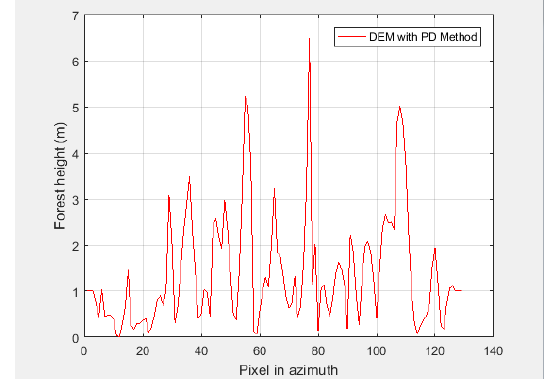
Figure 4. Height estimation result of DEM differencing method with PD coherence optimization